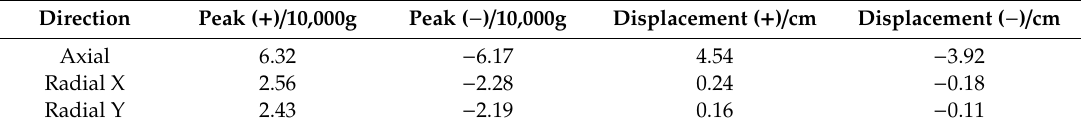
Table 2. Acceleration peaks of perforated string in axial, radial X and radial